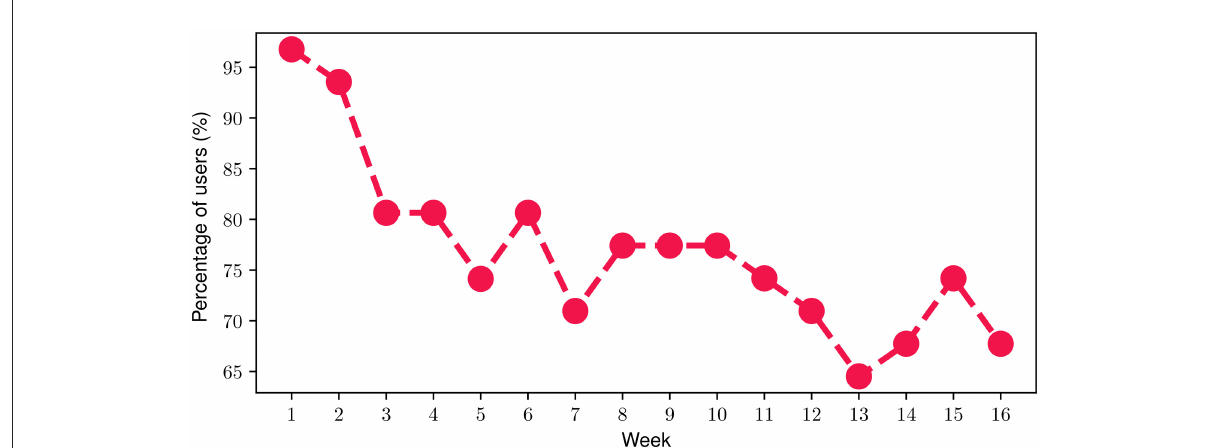
FIGURE5 Percentage of participants engaging with the FES during each week of the FP.